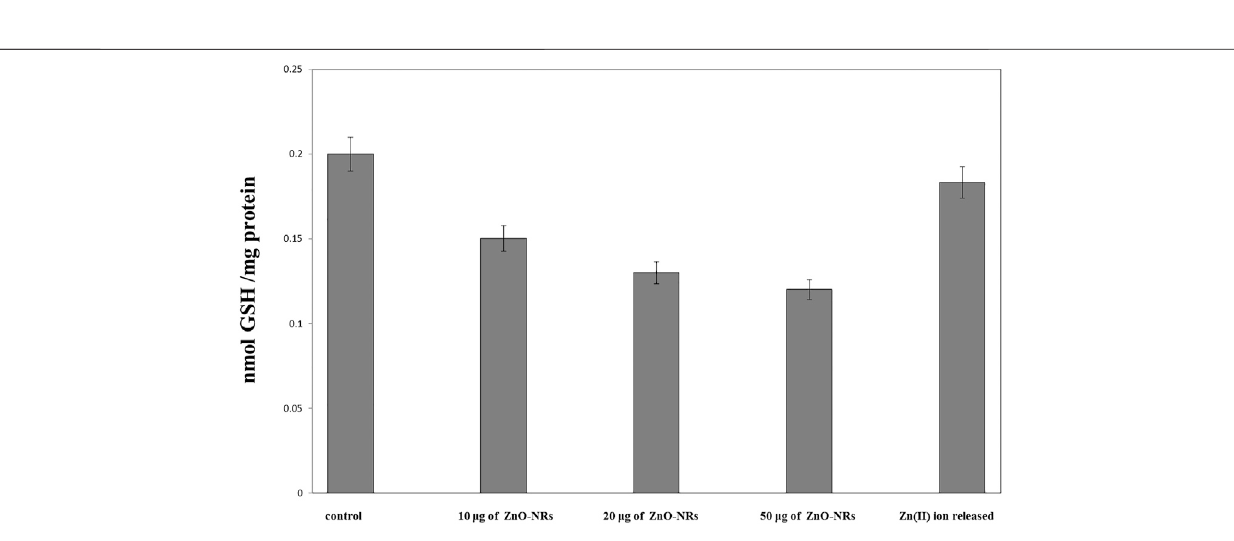
Frontiers in Pharmacology |